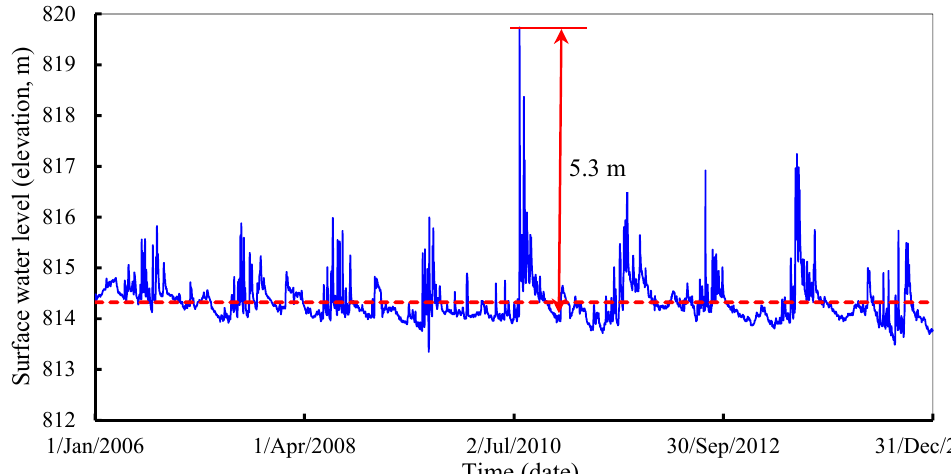
Figure 1. ( a ) Location of the field site near the Jingcun hydrometric station on Jinghe river. ( b ) Sat- ellite images of the field site. The orange dashed line is the Jiang river and the red dashed line is the surveyed line. ( c ) Photograph of the field site; the red dashed line is the surveyed line, along which the slug tests were conducted at different locations.